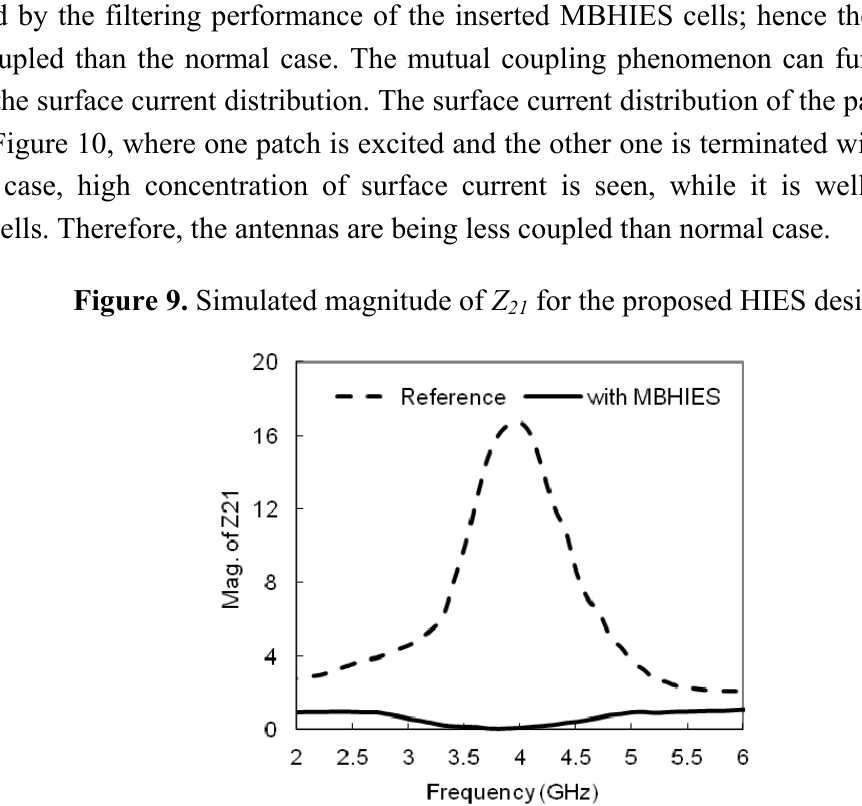
Figure 9. Simulated magnitude of Z